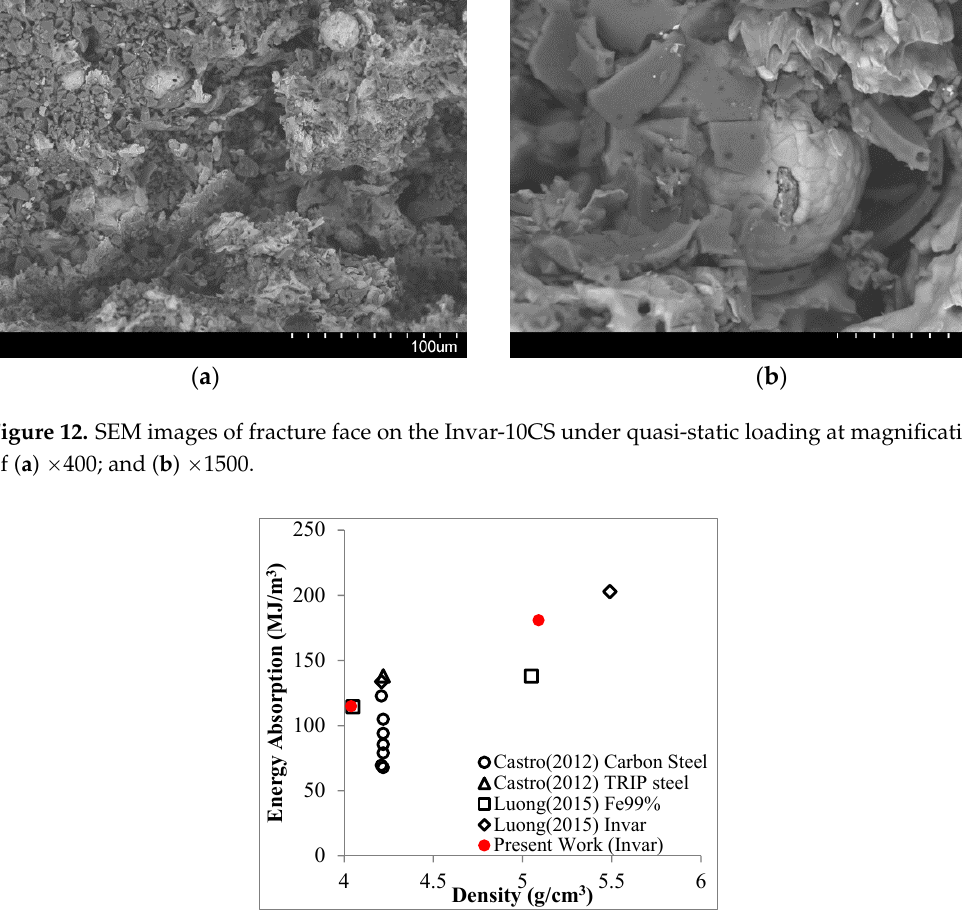
Figure 13. The energy absorption up to the strain of 50% of steel ‐ based matrix SFs.